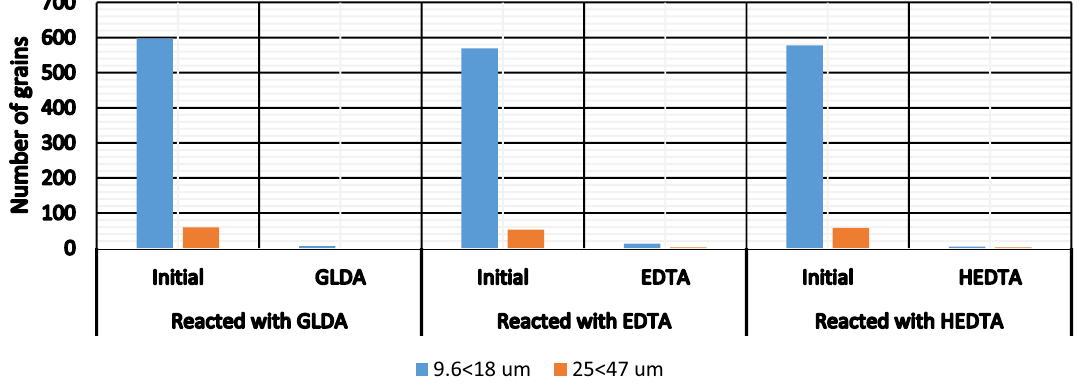
Fig. 14 The grain size distribution of Magnetite in Berea Sandstone before and after reaction with chelating agents